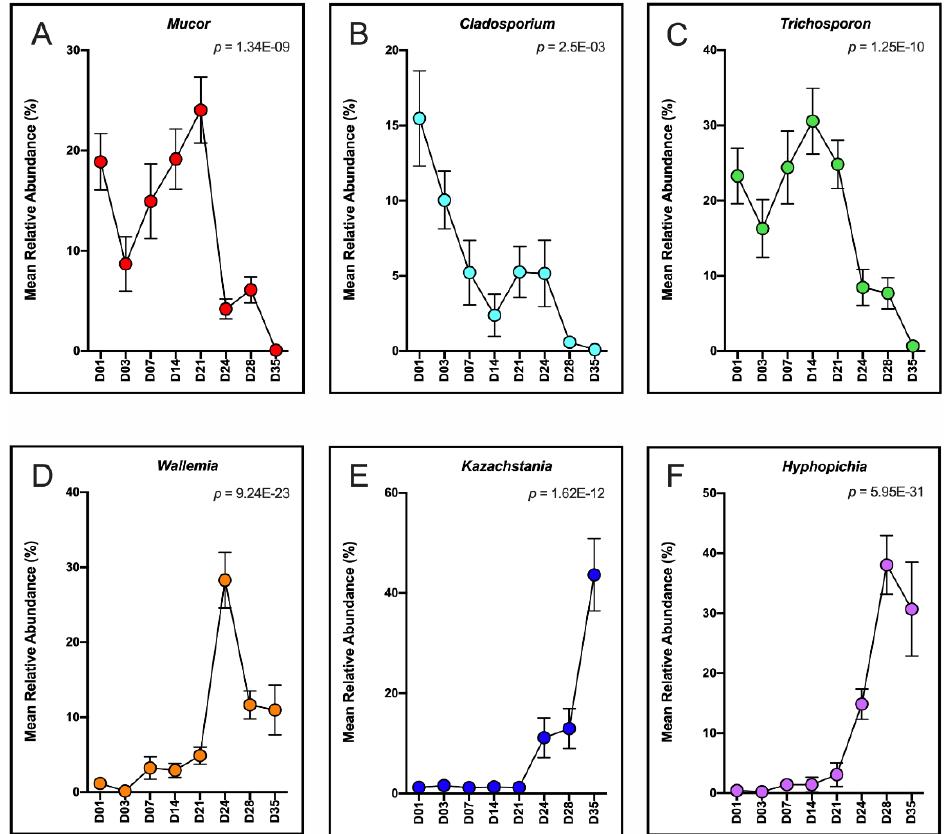
Figure 6. Differentially abundant genera over time in the piglet pre- vs. post-wean fecal mycobiome. Trends in mean relative abundances of significant fungal genera representing the ( A – C ) pre-wean (D01–21) and ( D – F ) post-wean (D24–35) piglet fecal mycobiome. FDR-corrected p -values were calculated using a linear mixed-effect regression model controlling for individual piglet. Error bars represent ± SE. A complete list of differentially abundant fungus is found in Table S5B.